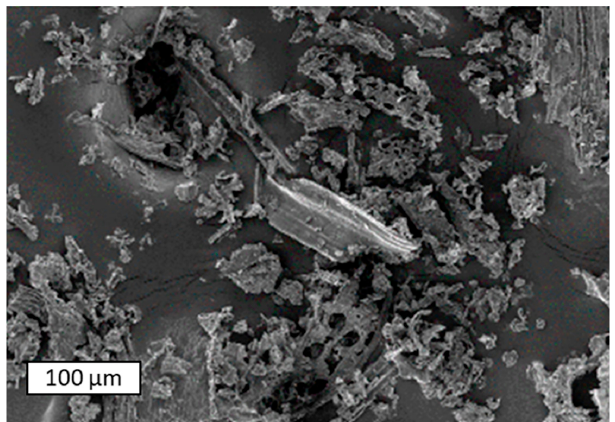
Figure 3. Powder ground with Ø0.5 smooth screen to a median size of 130 μ m. Magnitude 500×.